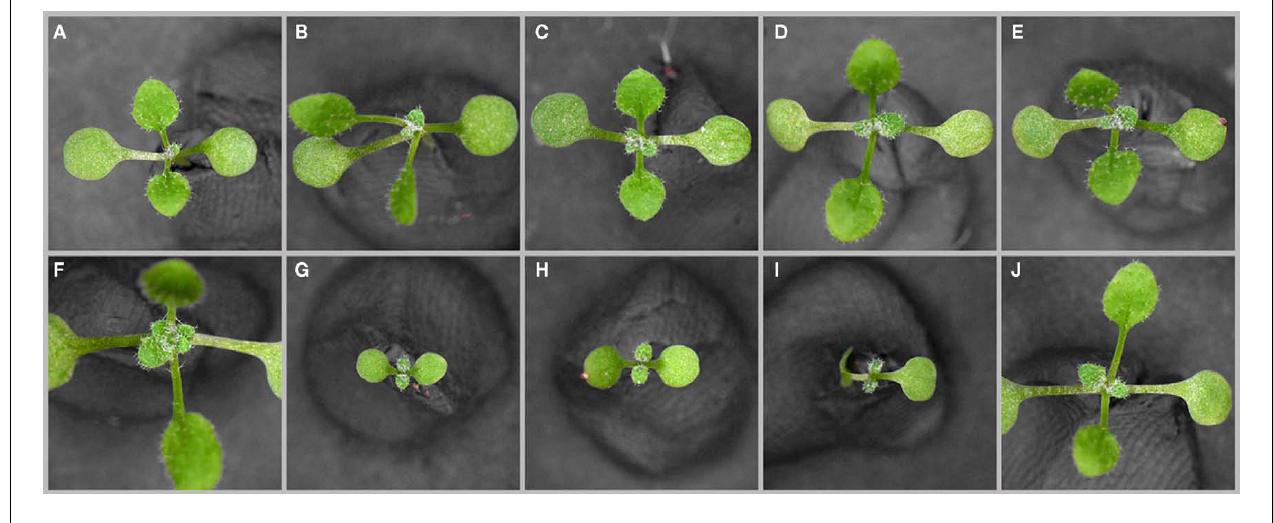
pan clv3 – 7 (F) , pan arr7 (G) , pan arr15 (H) , pan arr15 clv3 (I) , and arr7 arr15 (J) mutant plants. All plants were grown under LD and representative seedlings are